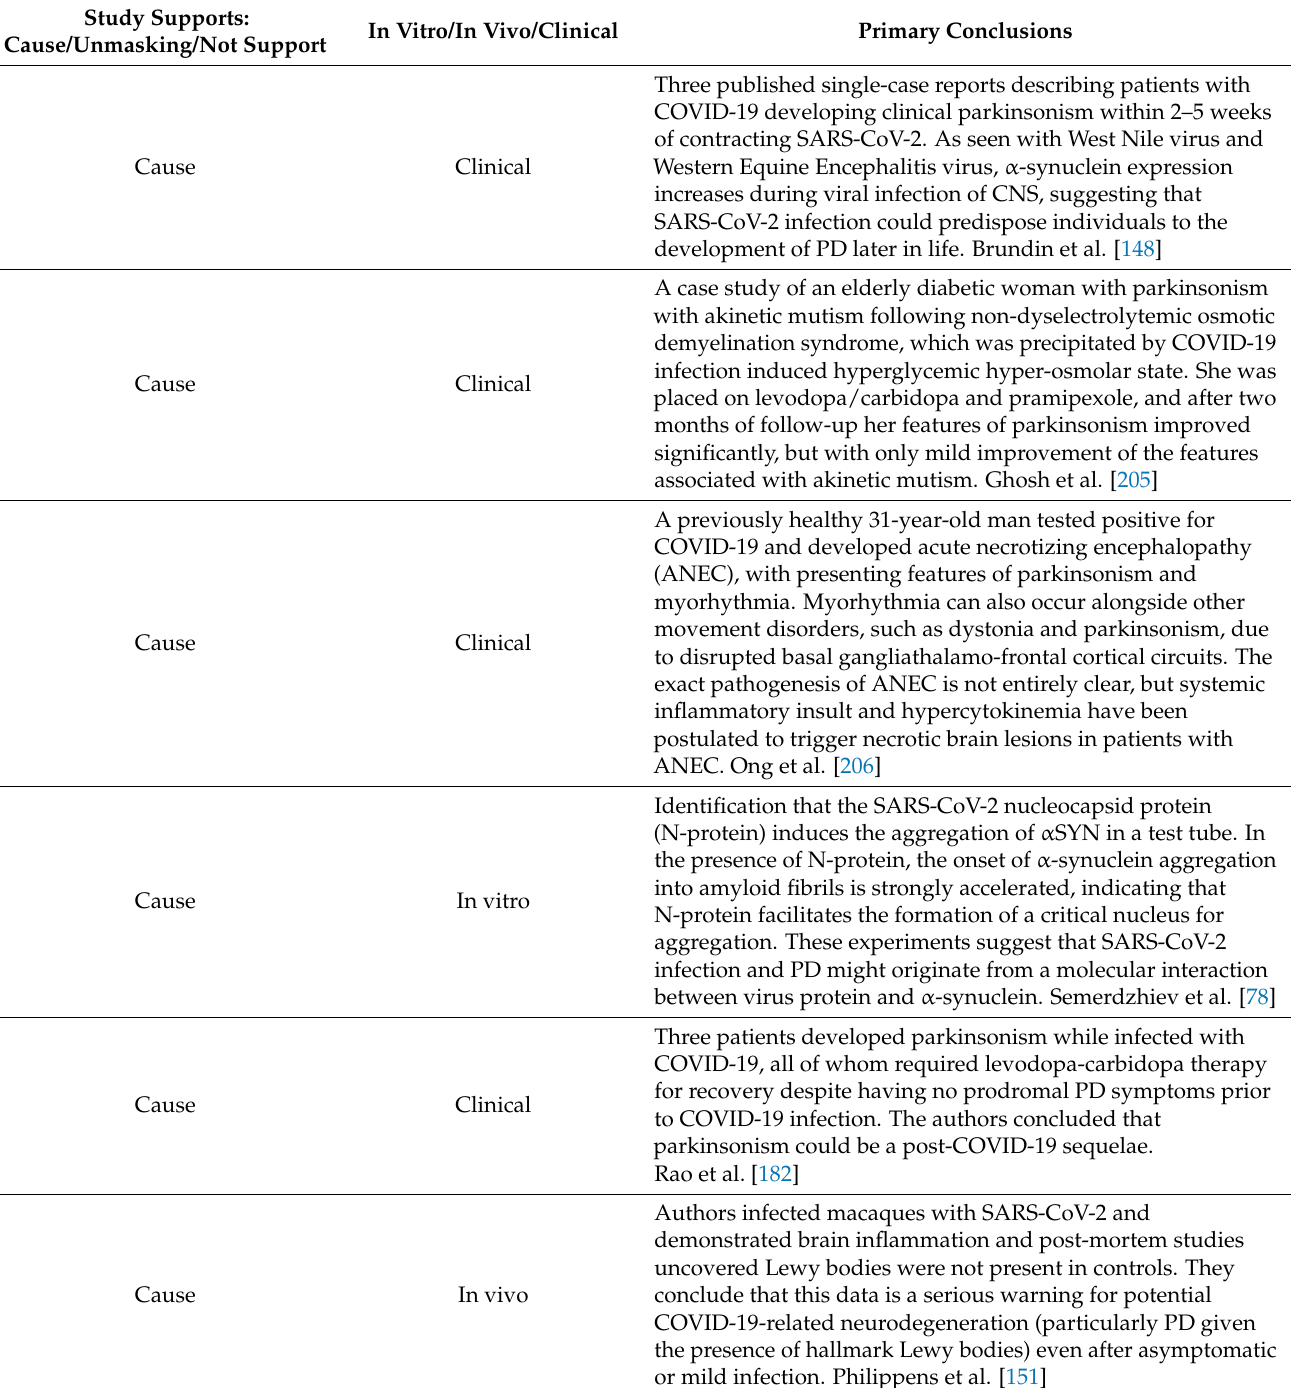
Table 1. Hypotheses and Studies that SARS-CoV-2 Promotes the Development of Parkinson’s Disease. Study